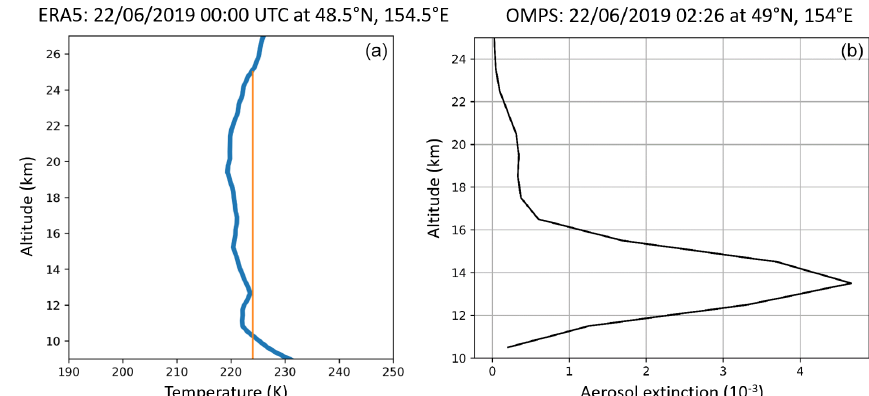
Figure A1. (a) ERA5 temperature profile (blue line) at the location of the minimum brightness temperature (orange line) of Himawari-8 observations of the Raikoke plume a few hours after the eruption. (b) OMPS aerosol extinction profile close to the Raikoke location shortly after the injection